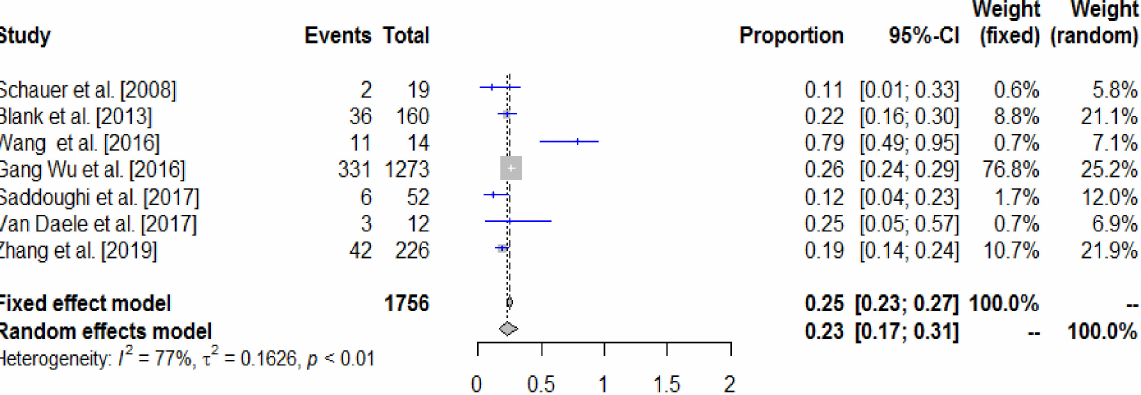
Figure 2. Comparison of 3-year survival rates (forest plot: the gray square represents the individual study effect and its size reflects the weight of the study in the overall analysis). Blue lines represent the confidence intervals of the studies. Studies with no or small squares, which have a lower weight, have greater confidence intervals than studies with large squares. The diamond represents the pooled results of surgery on 3-year survival. The outer edges of the diamond represent the confidence interval of this summary